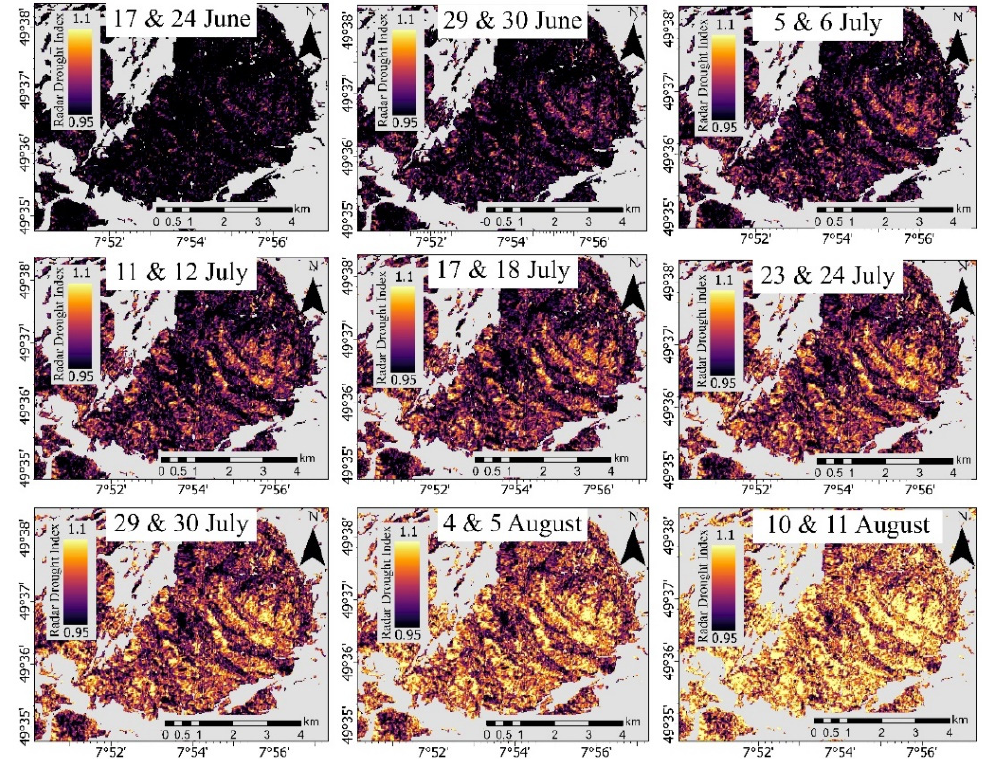
Figure 12. Temporal development of the RDI in the Donnersberg region for the period from the end